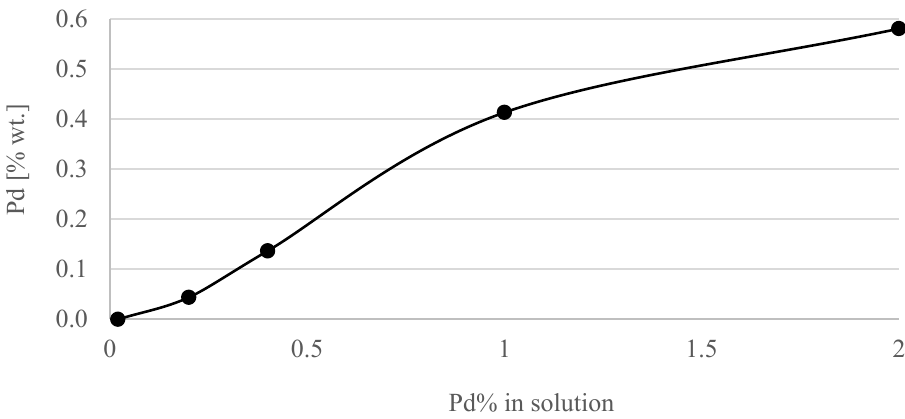
Figure 6. Adsorption of palladium on the surface of the TiO 2 /Ti support.